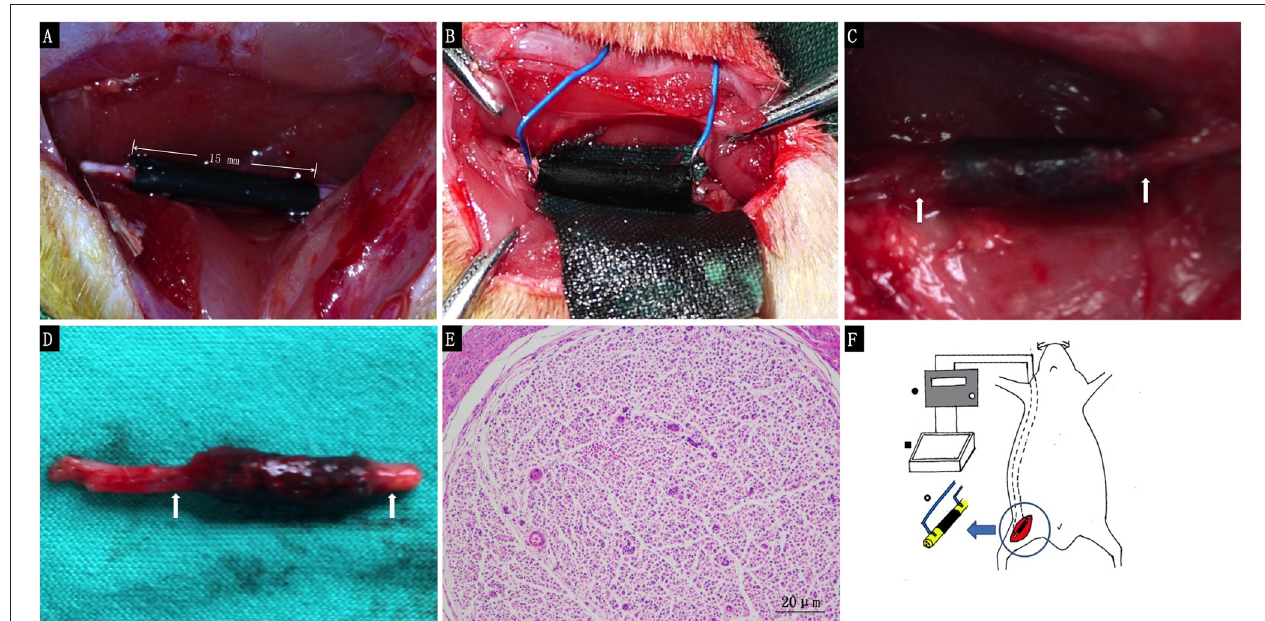
FIGURE 5 | The animal operation procedure. (A) Immediately after 15 mm conduit implantation. (B) 1/4 circle electrode implantation. (C) Eight weeks post-implantation. (D) Harvested regenerated nerve at 8 weeks post-implantation. (E) Histological section of the electrode contact site stained with hematoxylin and eosin 8 weeks post-implantation (White arrows: the electrode contact site). (F) Schematic illustration for animal procedure: a 15 mm sciatic nerve defect was bridged by PPY/PLCL conduits (right thigh, black), nickel-titanium alloy wire was placed into the proximal and distal segments with a 1/4 circle electrode and buried behind the neck through the sub cutaneous tunnel ( • Electronic Stimulator (cid:4) special made cell culture dish ◦ tact site of the electrodes to the conduit).